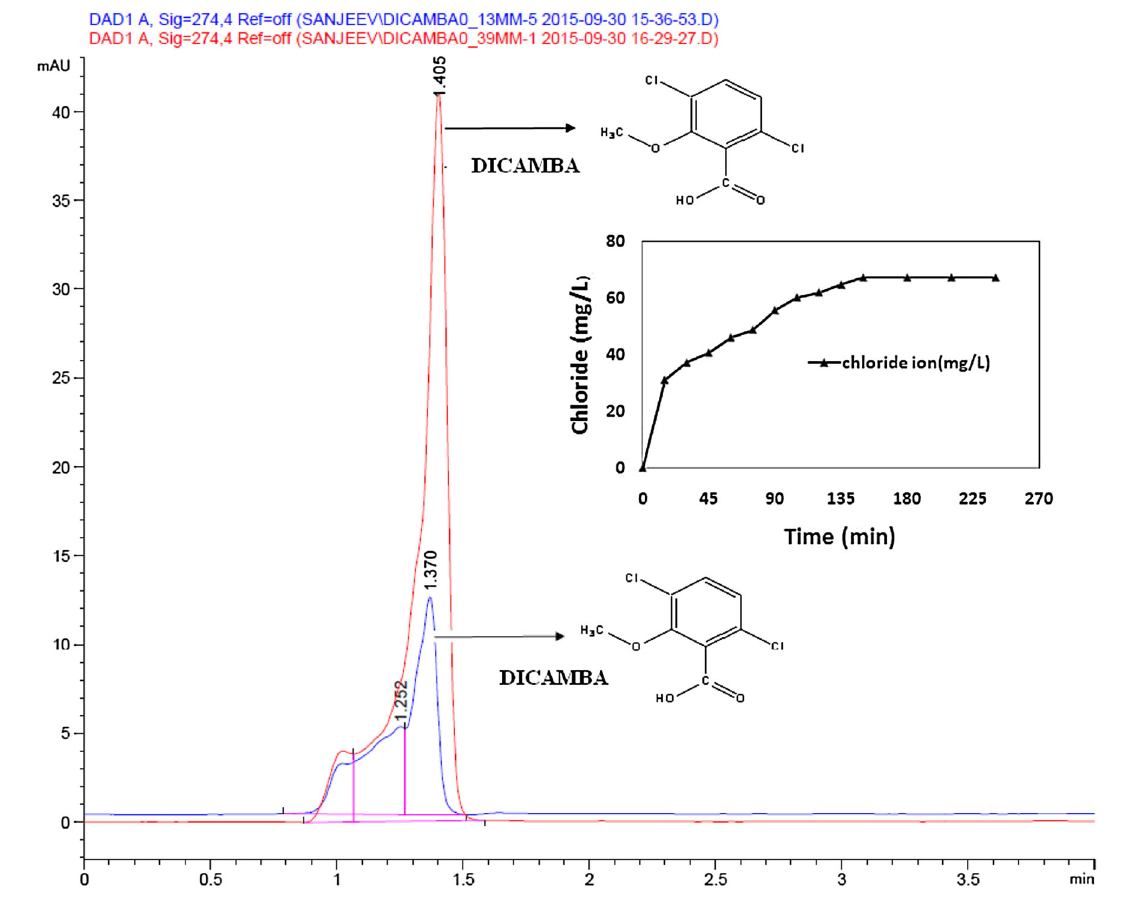
Fig. 6 HPLC along with LCMS analysis